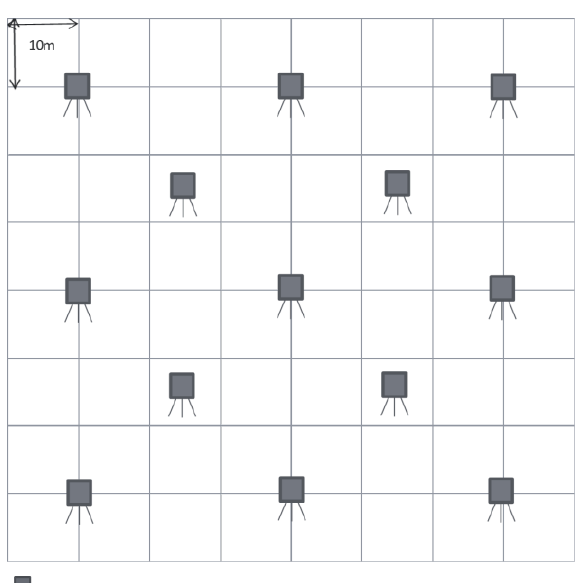
Figure 1. Locations of terrestrial laser scanning (TLS) measurements within the